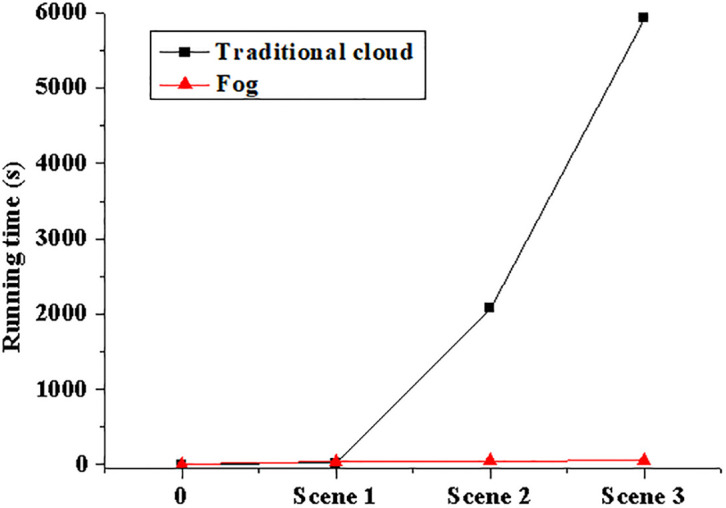
Comparative analysis of running time of different schemes under each scenario.